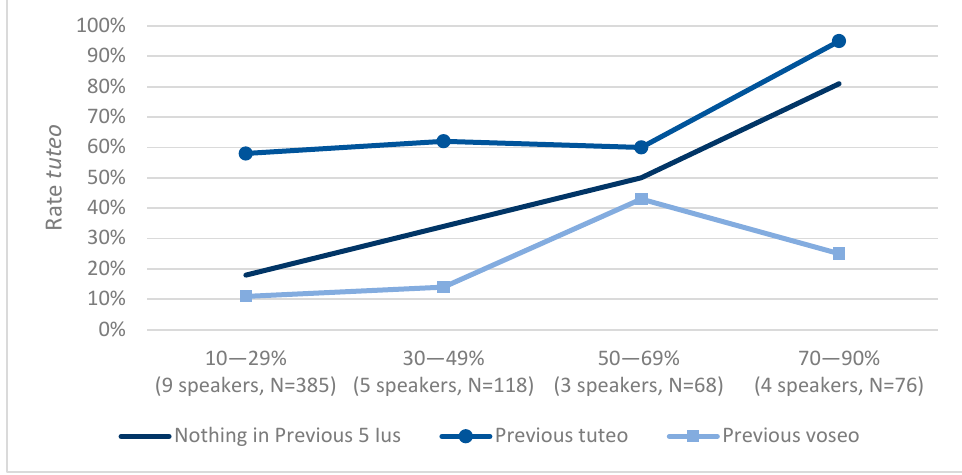
Figure 4. Rates of tuteo vs. voseo by previous realization comparing speakers binned according to their overall rate of tuteo .